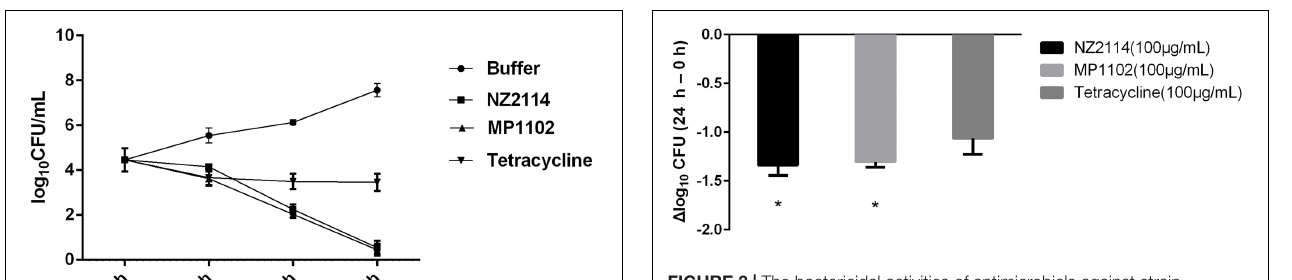
Frontiers in Microbiology |